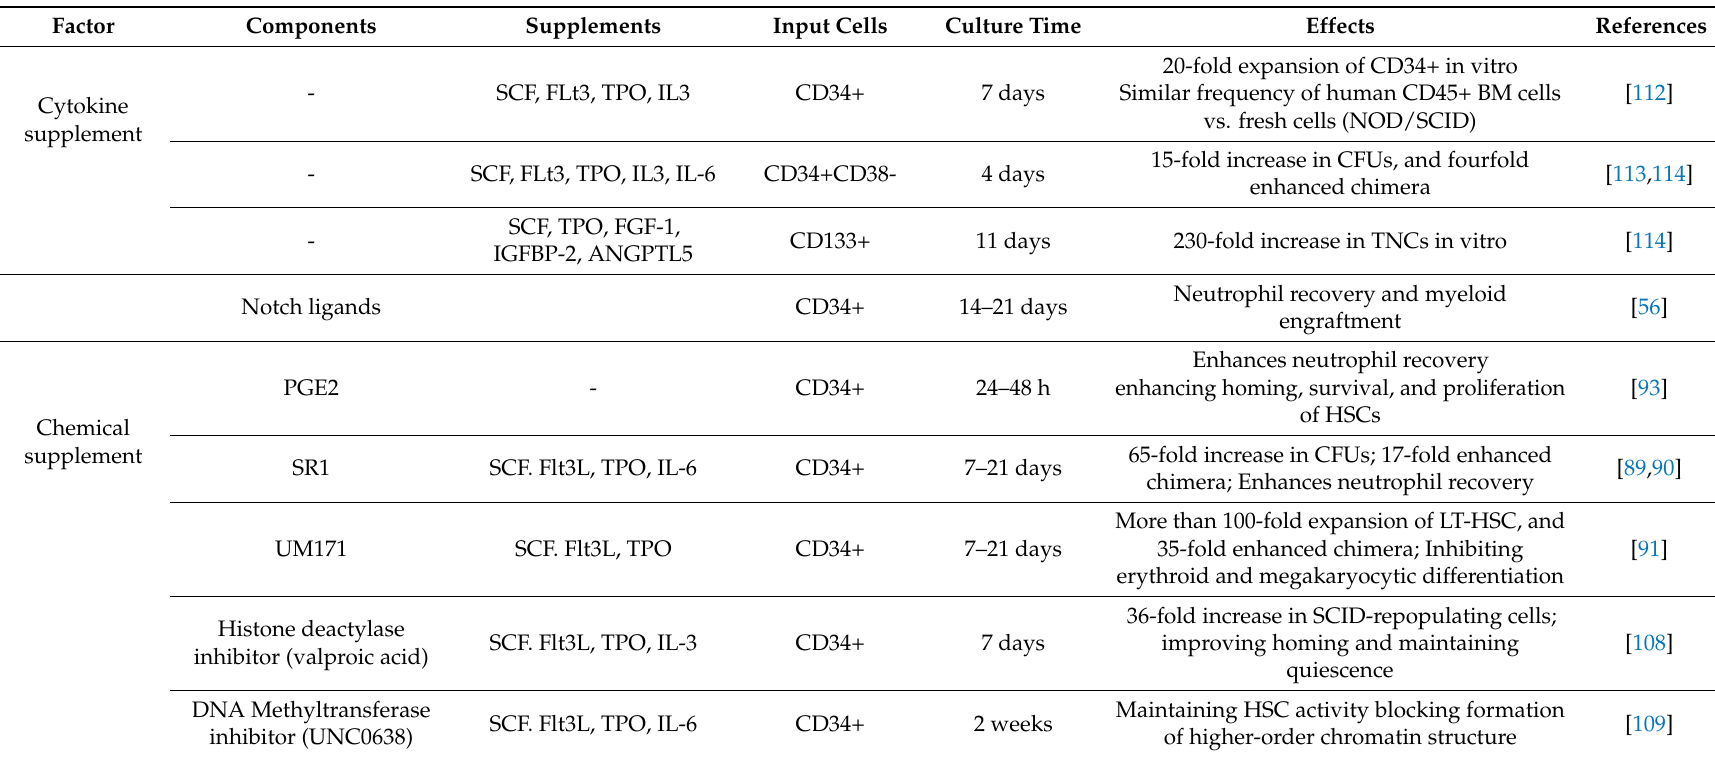
Table 1. Summary of current protocols of ex vivo expansion of human